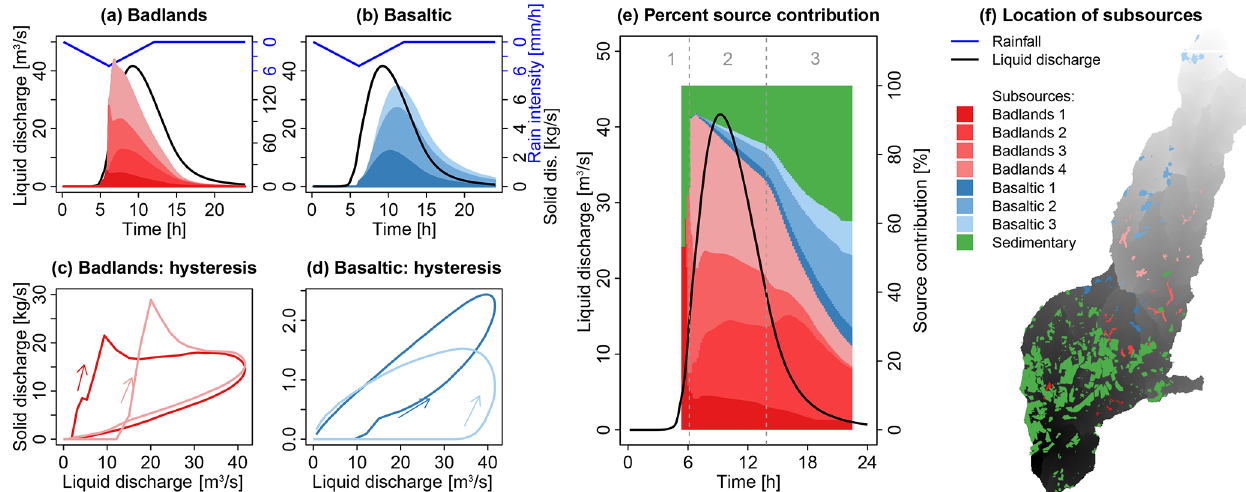
Figure 12. (a, b) Contribution of subsources of badlands and basaltic sources that are classified according to their distance to the outlet (Sc. 4a). The colored areas show the contribution of sources close to the outlet (darker colors) and more distant sources (lighter colors) from the sedigraph. (c, d) The hysteresis loops of the subsources. (e) The contribution of each subsource to total solid discharge in percent. The dashed lines and the grey numbers above the figure distinguish different periods of the event as referred to in the text. (f) Location of the subsources in the Claduègne catchment.